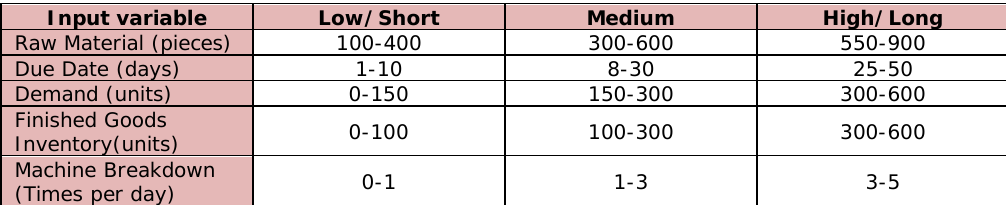
Table 1. “Variation of input linguistic variables”. Source: Own contribution